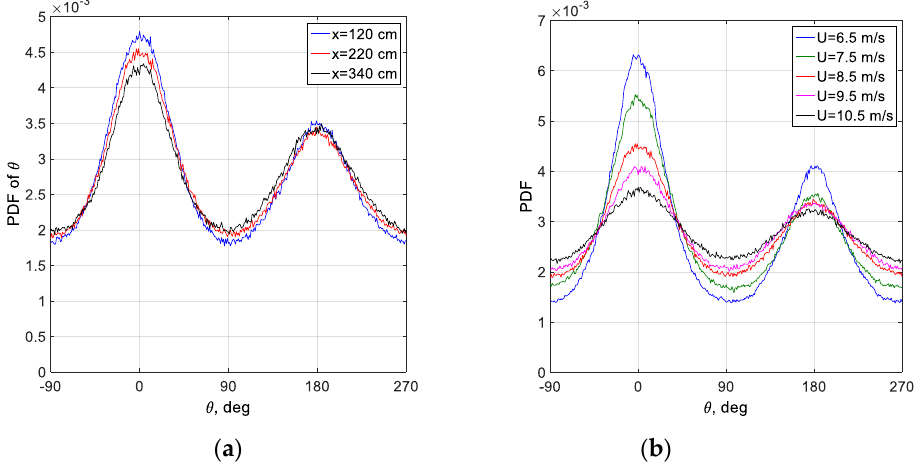
Figure 17. Probability density function of the instantaneous slope inclination direction θ : ( a ) for U max = 8.5 m/s and three fetches; ( b ) for x = 220 cm and different wind velocities U max. The measured by LSG temporal dependencies of downwind ∂η / ∂ x( t ) and crosswind ∂η / ∂ y( t ) slope components allow comparing their frequency spectra with those of the surface elevation η ( t ).